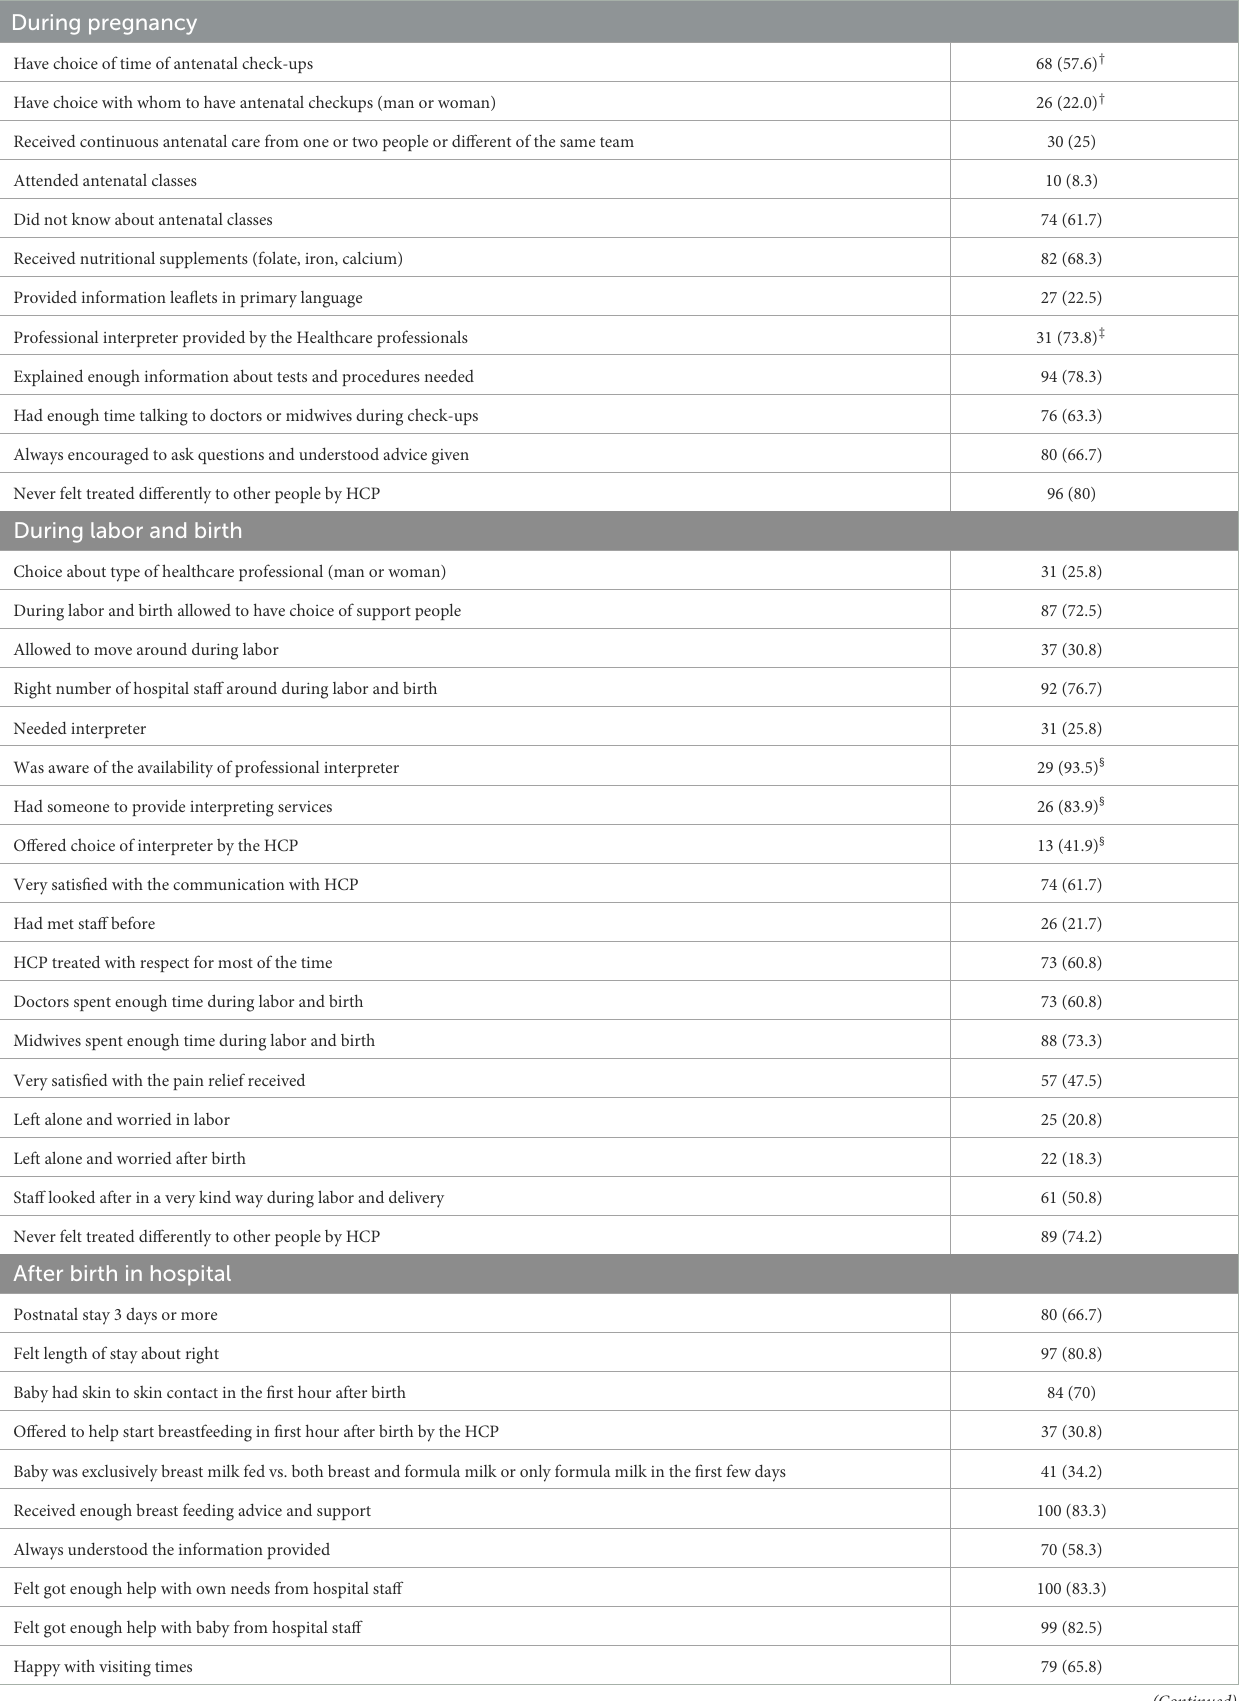
TABLE 3 Access to care, information exchange and perceptions of care during the three phases of maternity. During